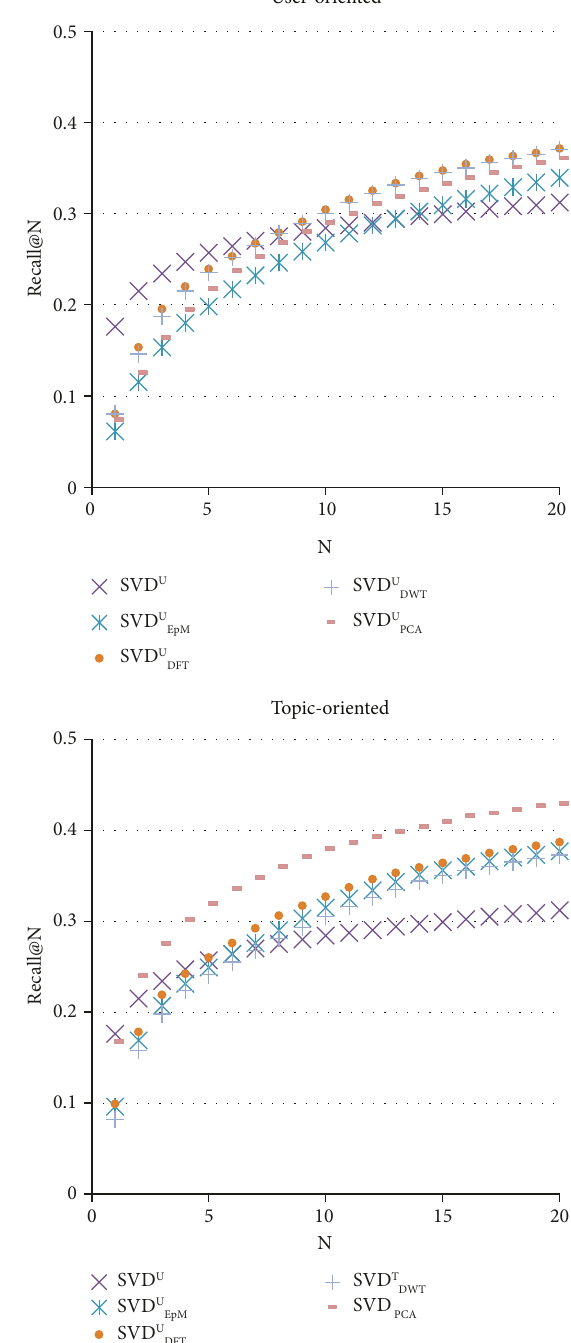
Figure 6: Explainability of user/topic behavior interior